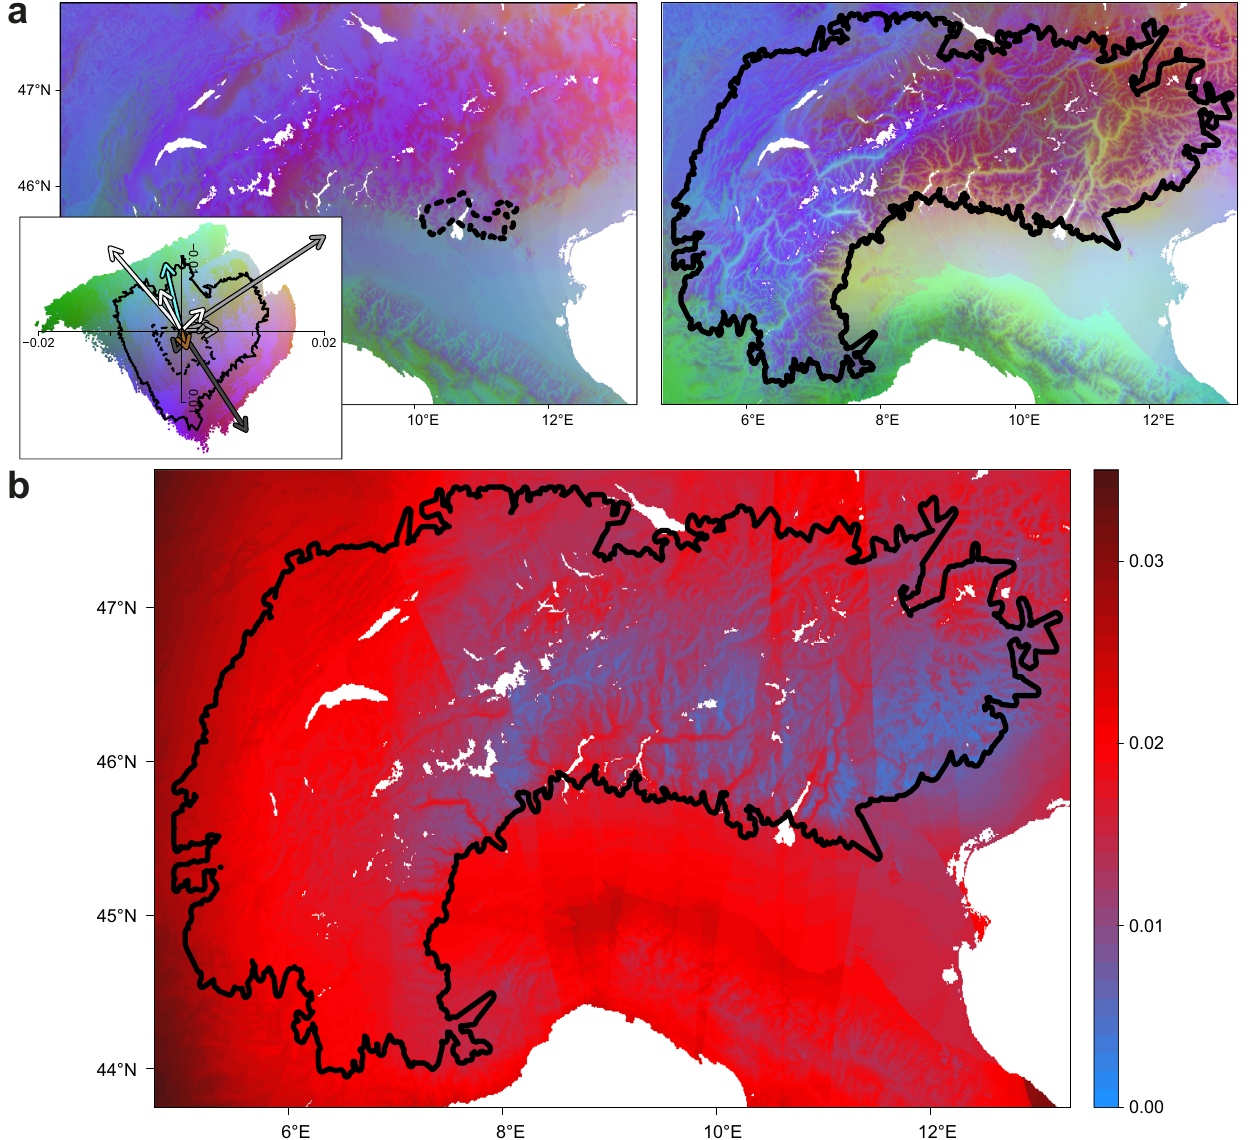
Fig. 5 | Heterogenous climate shifts drove spatio-temporal sieving of alleles. A Projections of adaptive genomic composition across geographic space, for the last glacial maximum (LGM) (left) and present-day (right). Areas with similar col- ours are predicted to harbour populations with similar adaptive genomic compo- sition, while divergent colours indicate populations with divergent adaptive genomiccomposition.Coloursarebasedonthe fi rstthreeprincipalcomponentsof transformed climate variables (aka eigenvectors describing the composition of genetic variation), where each principal component (PC) is plotted as a separate colour channel in RGB space (PC1 - red, PC2 - green, PC3 - blue). The left inset, applicable to both time projections, shows the loadings (i.e., direction and mag- nitude)ofallenvironmentalvariableswithrespecttothe fi rst2PCsoftransformed climate space, with arrows colour-coded as follows: white - temperature variables,